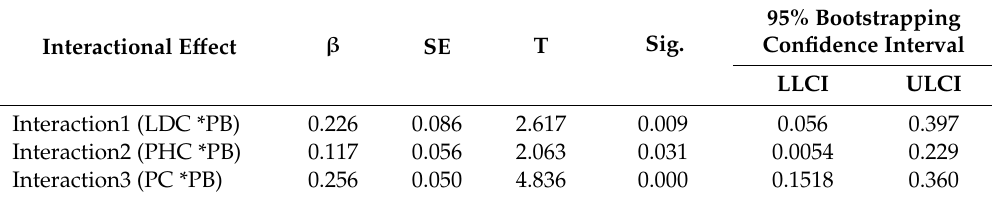
Table 4. Moderation